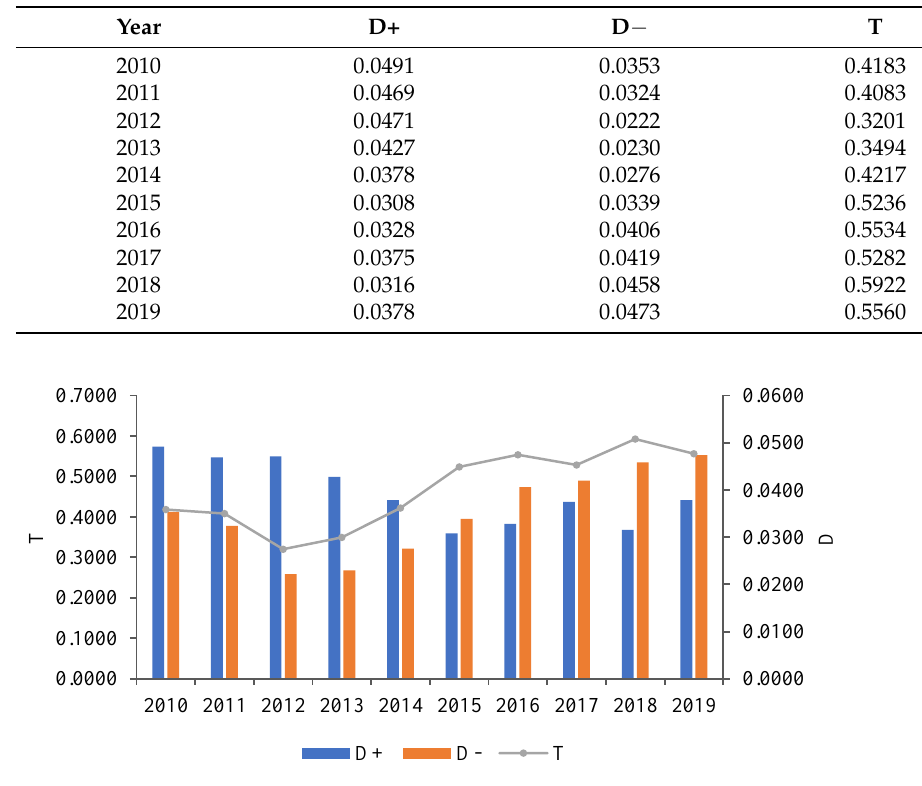
Table 4. Comprehensive evaluation values of water resource carrying.